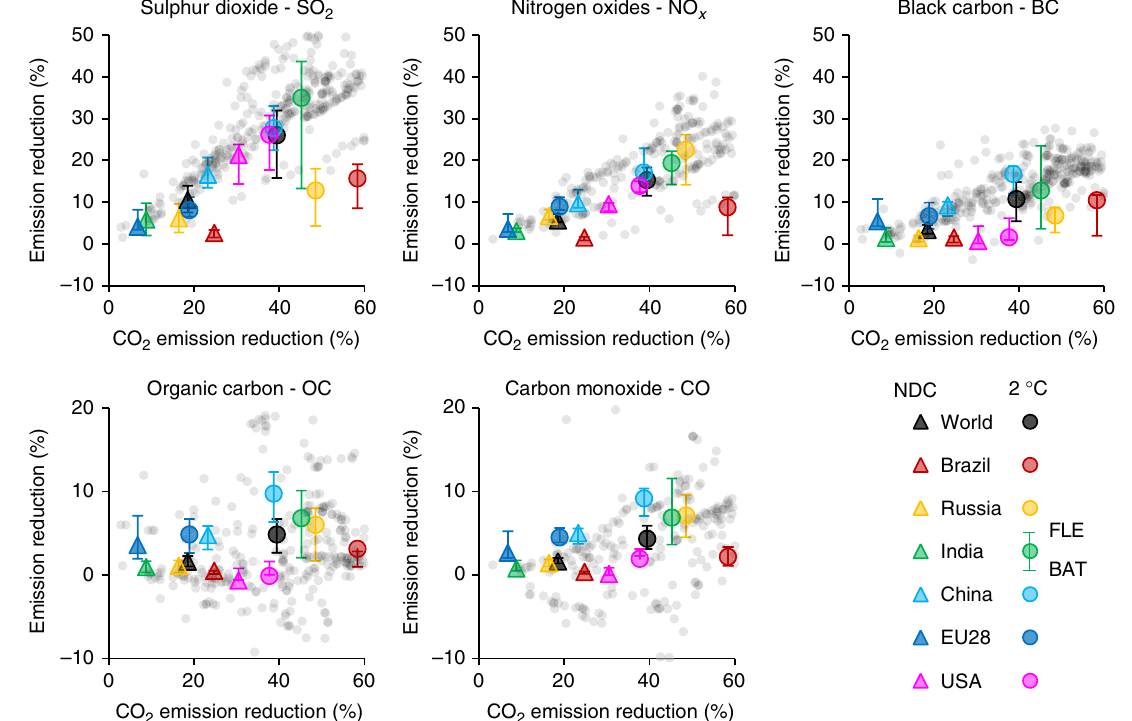
Fig. 2 Co-movement of emissions of CO 2 and air pollutants per region due to climate change mitigation policies. Emission reductions are expressed as percentage difference from the respective Reference climate scenario emissions cumulative over 2015 – 2050. Symbols represent the results for the Stringent Legislation air quality scenario, while the whiskers indicate the results for the Fixed Legislation (FLE) and Best Available Technologies (BAT) air quality scenarios. Grey dots show global results obtained from IPCC AR5 WGIII